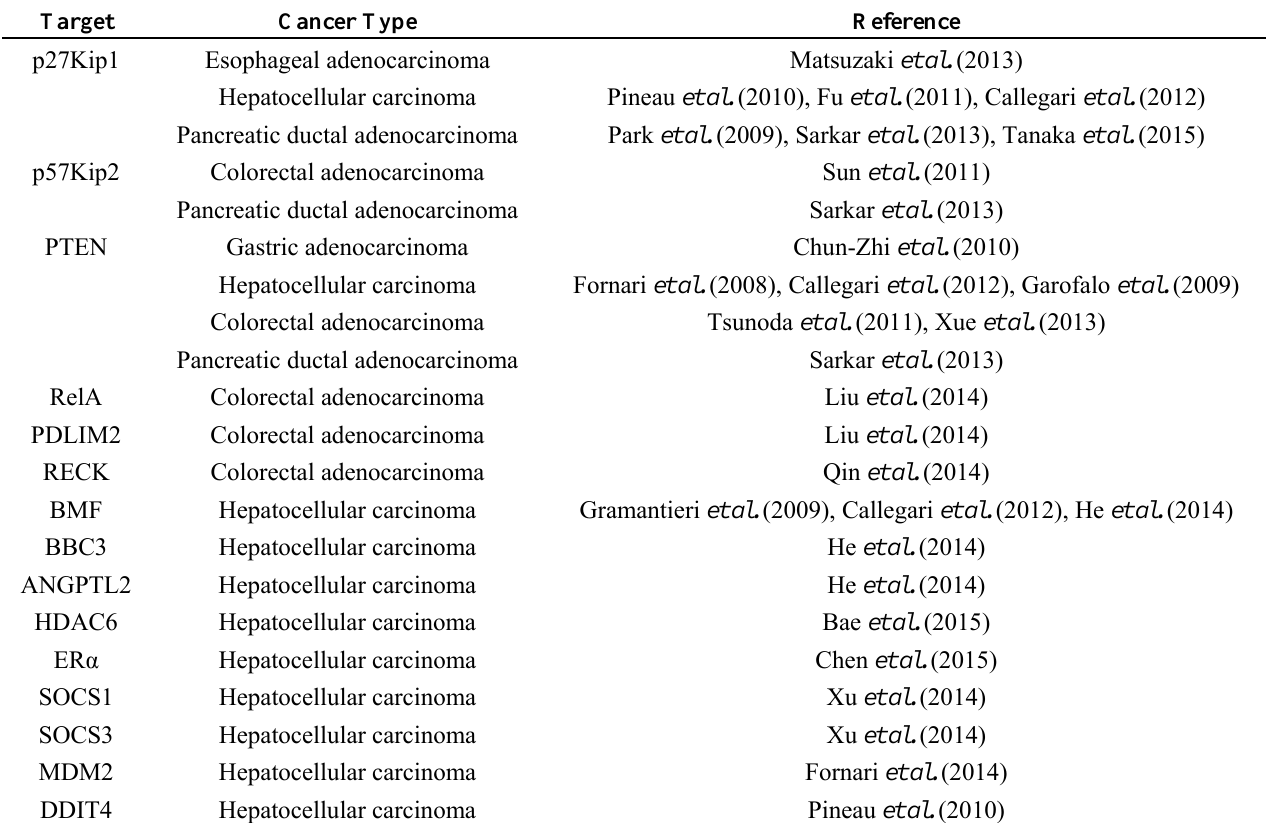
Table 1. Direct targets of miR-221/222